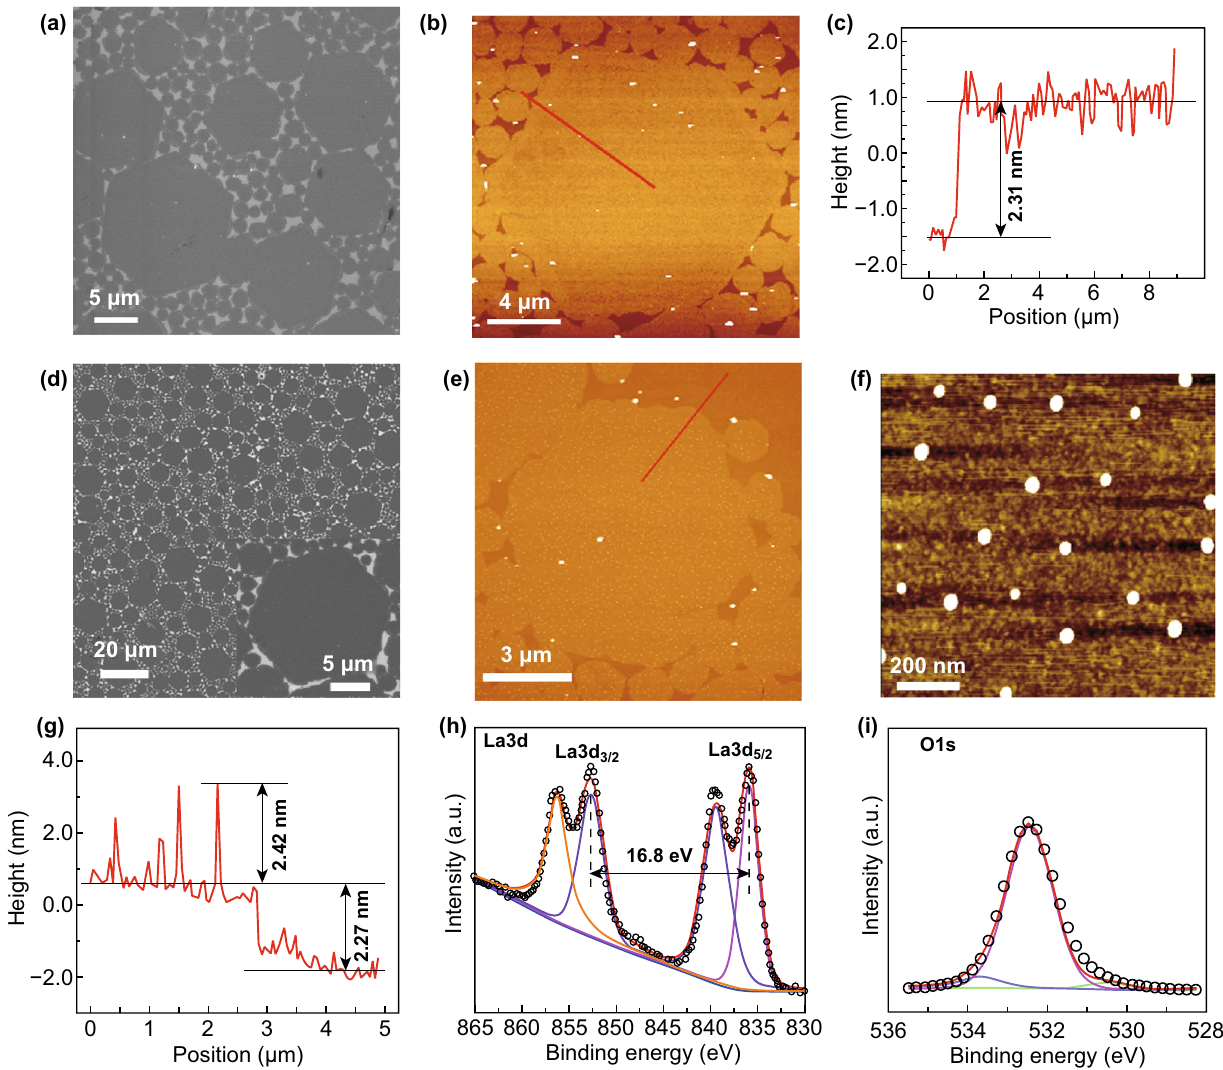
Figure 1 Morphology and elemental information of La 2 O 3 nanosheets and La 2 O 3 @NP-NS. a SEM image of La 2 O 3 nanosheets on a silicon substrate. b AFM topography scan of La 2 O 3 nanosheets. c Height profiles derived from the red line in b . d SEM image of La 2 O 3 @NP-NS on a silicon substrate at low magnification. Inset is high-magnification SEM image of La 2 O 3 @NP-NS. e AFM topography scan of La 2 O 3 @NP-NS. f High-magnification AFM topography scan of La 2 O 3 @NP-NS. g Height profiles derived from the red line in e . h La 3 d and i O 1 s XPS spectrum of